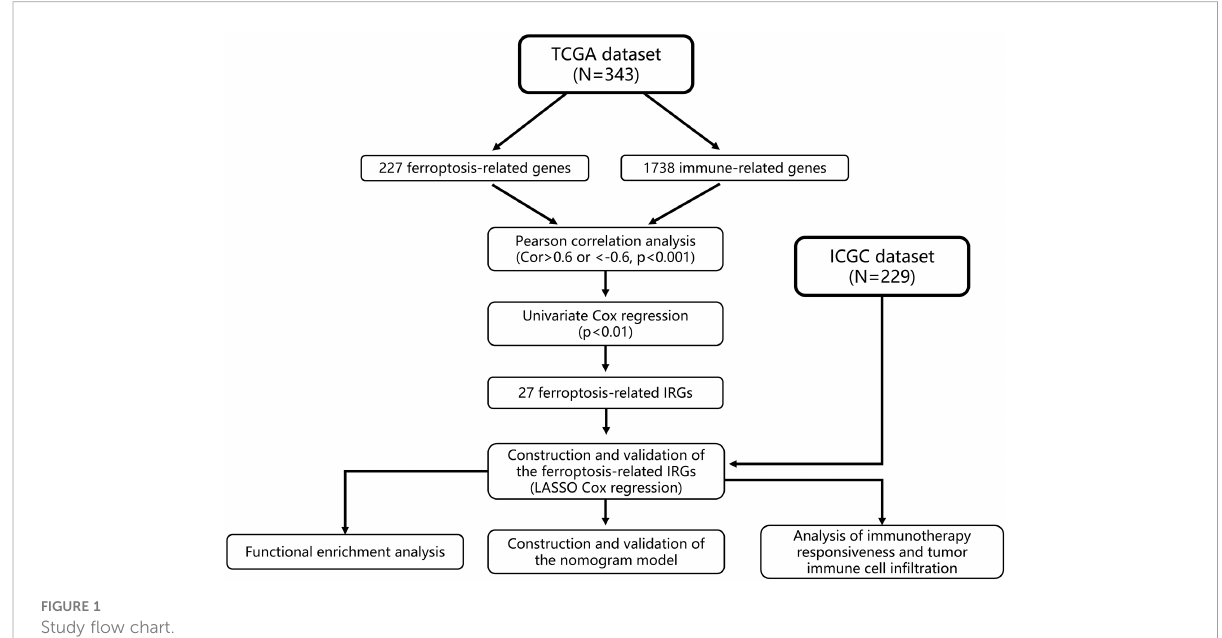
FIGURE 1 Study fl ow